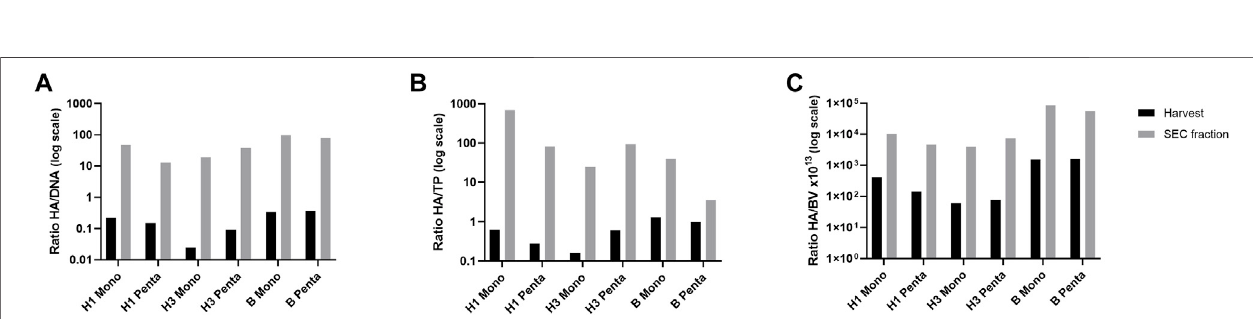
FIGURE3| EstimationofHAtitersandmajorprocess-relatedimpurities. (A) HA(µg/ml)toDNA(µg/ml), (B) HA(µg/ml)tototalprotein(mg/ml),and (C) HA(µg/ml)to baculovirus concentration (copies/ml × 10 13 ) ratios. Log scale is used for visualization purposes. Black bars represent VLP samples after harvest. Grey bars represent VLP samples after downstream processing (SEC fraction